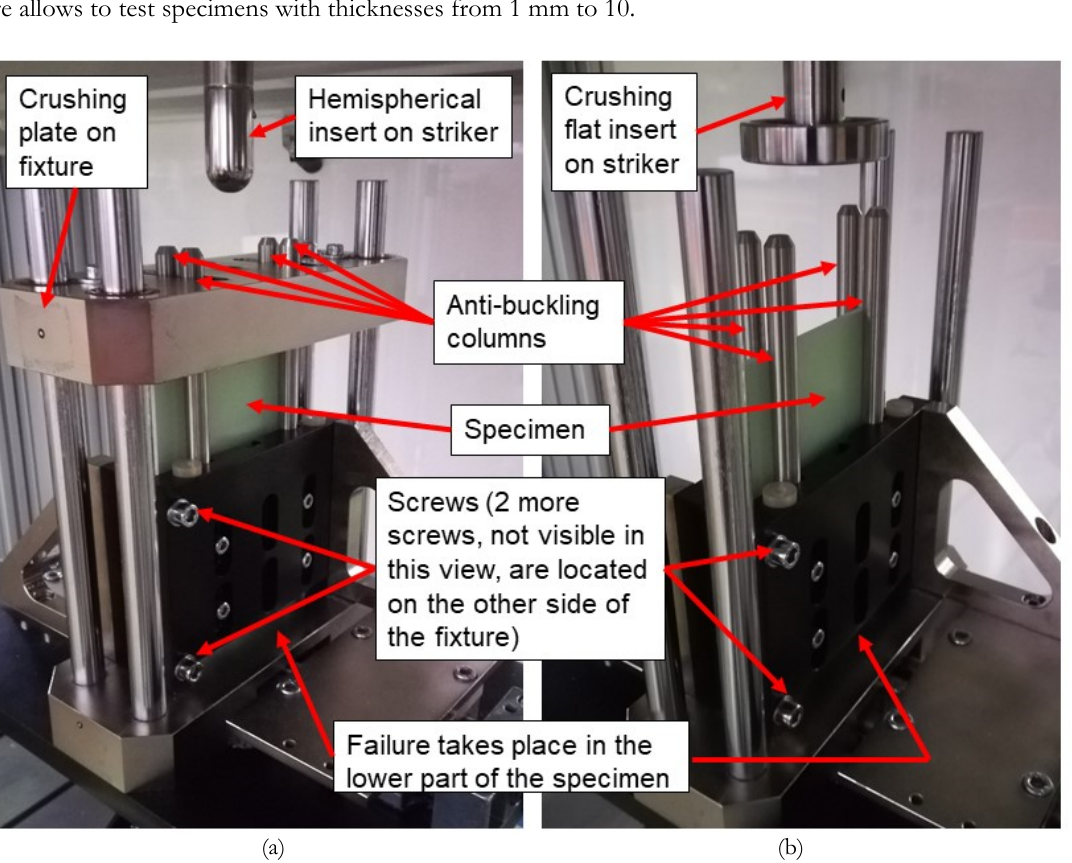
Figure 2: Fixture for crashworthiness test in two different configurations: (a) fixture with crushing plate on top, (b) fixture with crushing insert on the striker, and crushing plate